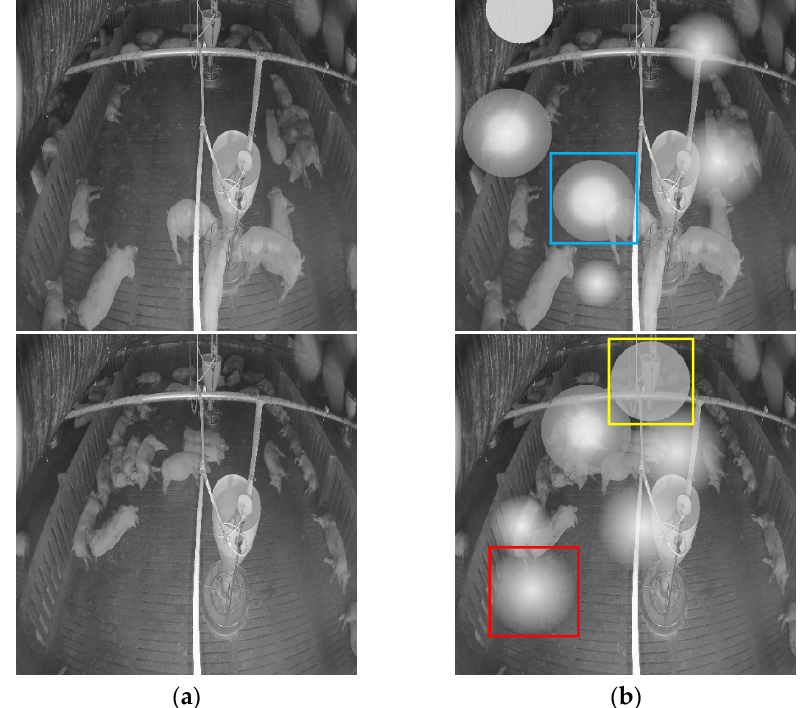
Figure 8. The clean image and simulated noisy image used to train the model. ( a ) Clean image; ( b ) Corresponding noisy image with simulated noise. The uniform noise, linear ‐ form noise, and exponential ‐ form noise are shown in yellow, blue, and red boxes, respectively.